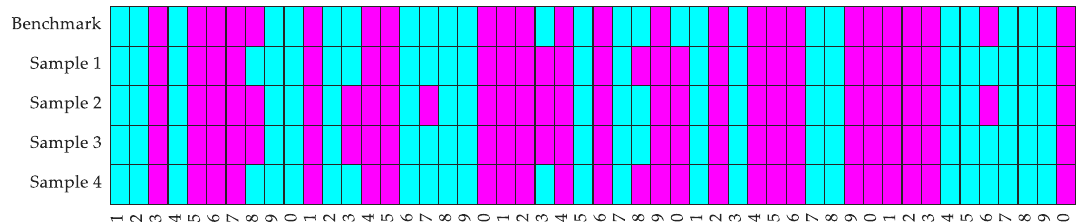
Figure 15. Graph of cocoon index vs. predicted gender for the sample